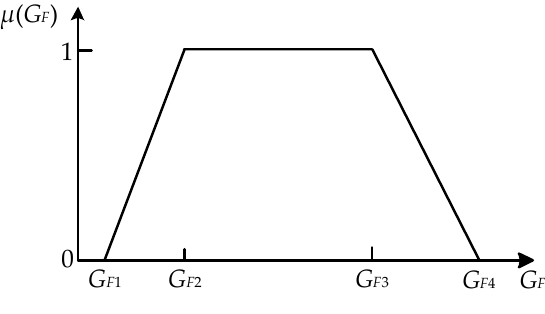
Figure 2. Trapezoidal fuzzy parameters.